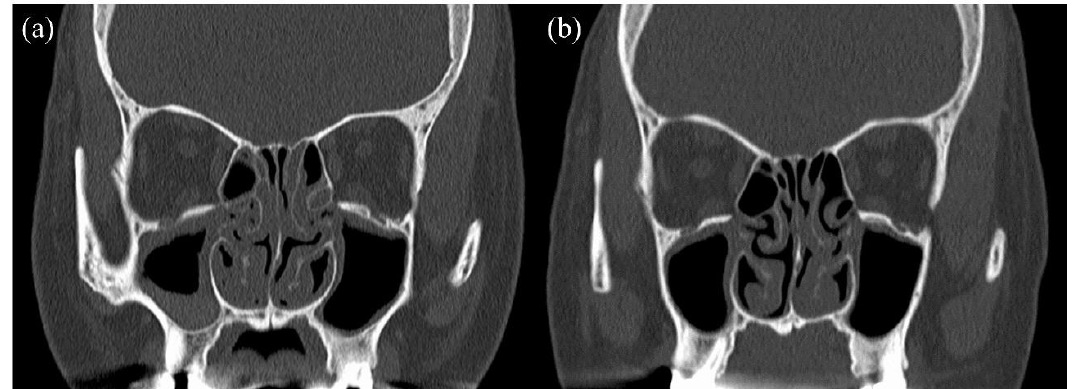
Figure 2. Sinus CT before and after sequential biotherapy: ( a ) before sequential biotherapy, ( b ) after sequential biotherapy for 7 months.